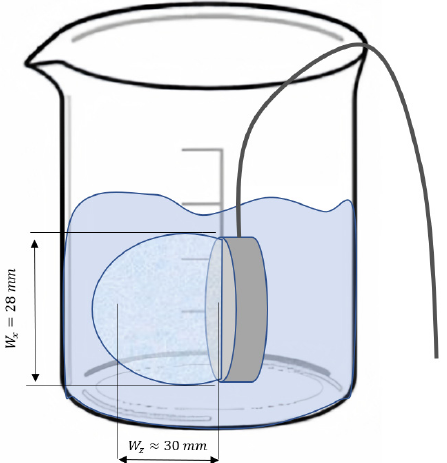
Figure 1. The experimental setup and volume of measurement. A probe is immersed into a liquid. The averaging volume is 28 mm in width (denoted W x ) and approximately 30 mm in depth (denoted W z ). Microwave emissions from the liquid are